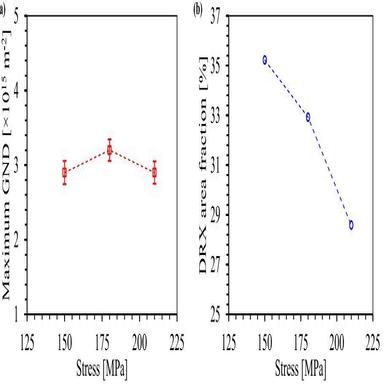
(a) GND as a function of stress and (b) DRX area fraction as a function of creep stress.